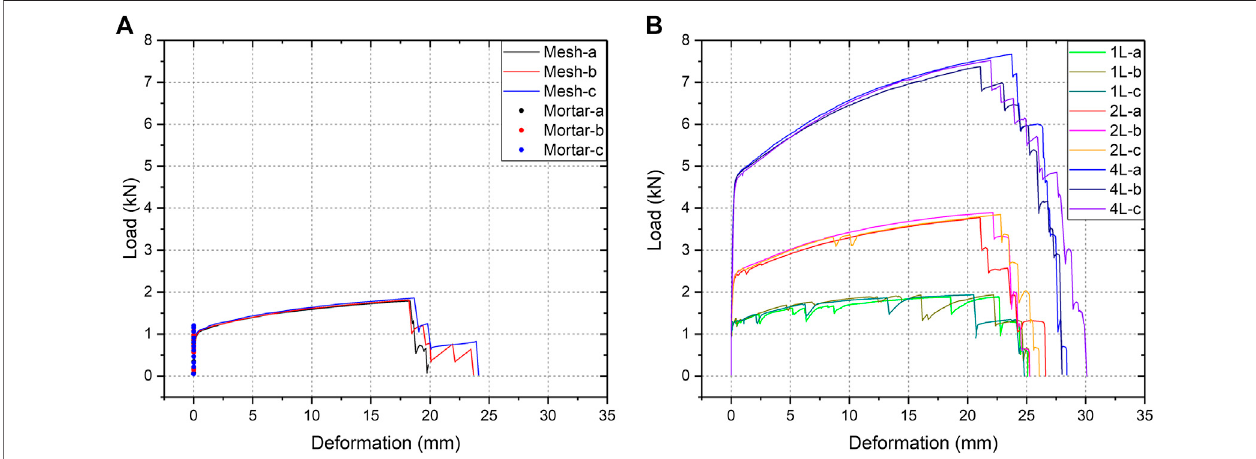
FIGURE5| Axialload – deformationrelationships ofmesh, AASmortar,andferrocement. (A) MeshandAASmortar specimenand (B) AASferrocementspecimen. A10M.